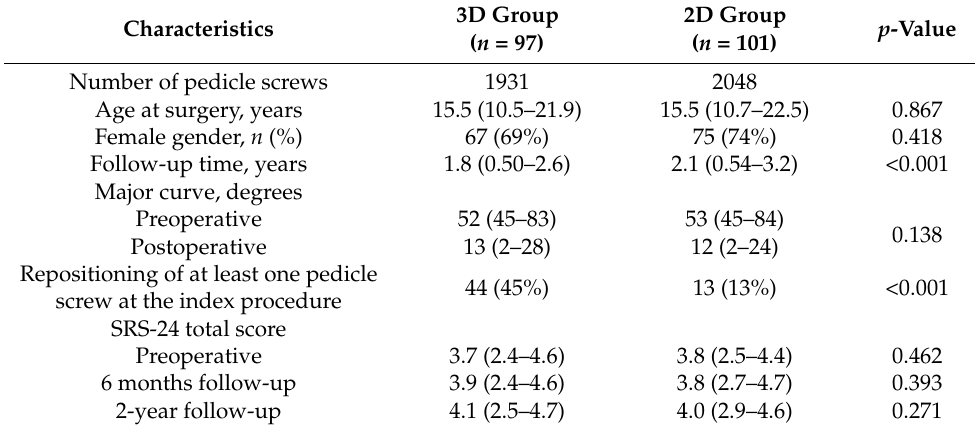
Table 1. Clinical characteristics of the study